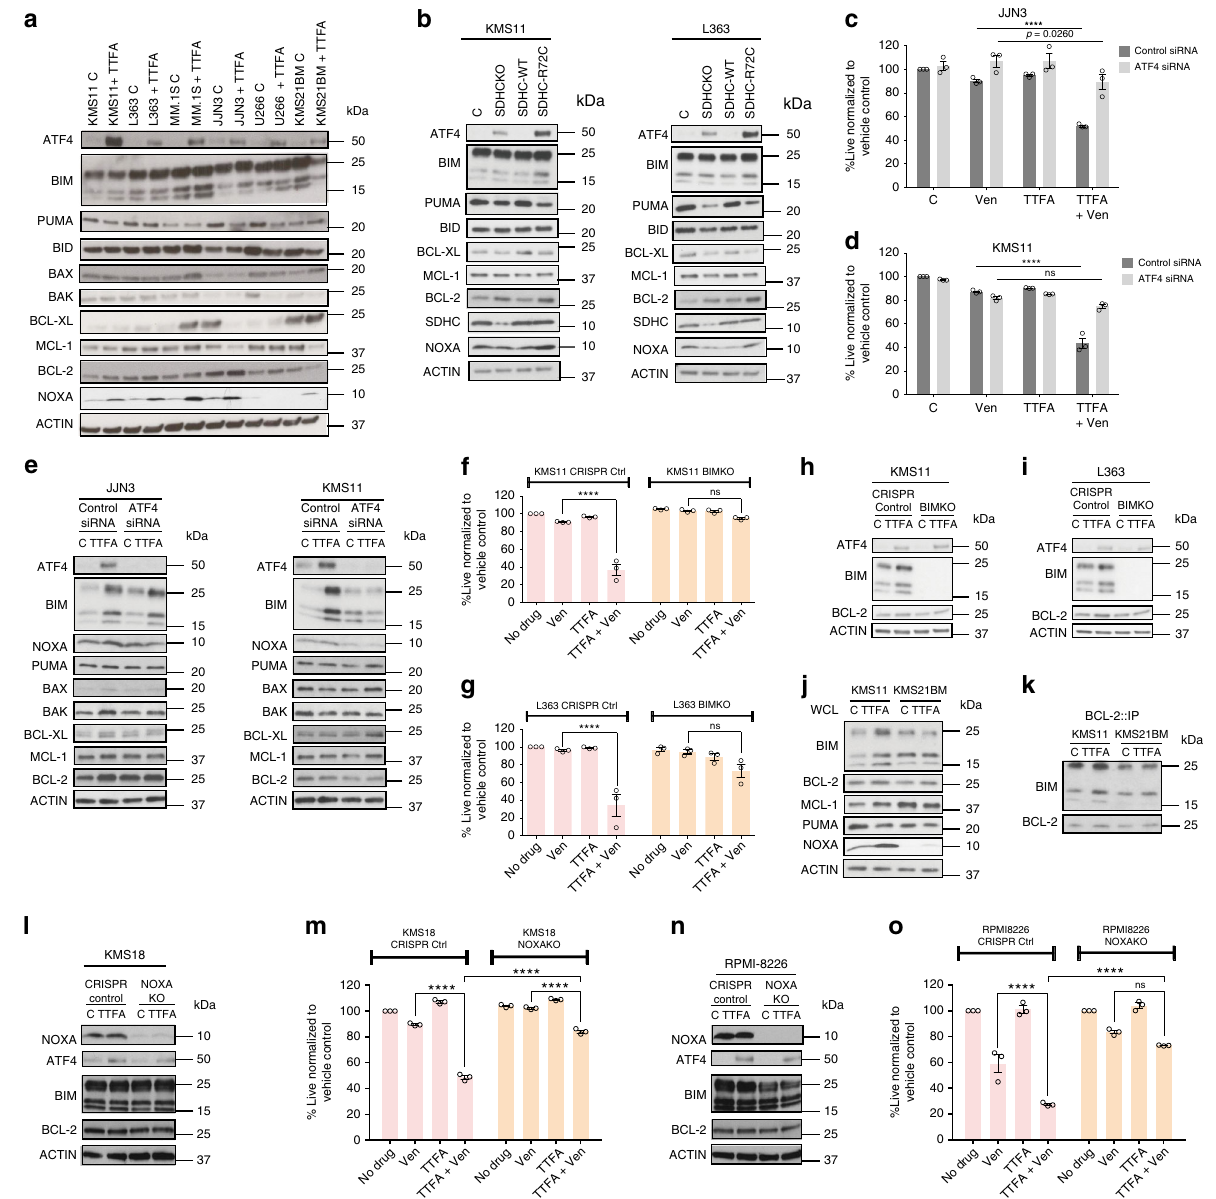
Fig. 5 ATF4, BIM and NOXA regulate TTFA-induced venetoclax sensitivity in MM. a Expression of ATF4 and the indicated pro- and antiapoptotic proteins was evaluated in whole cell lysates of the indicated lines treated with ±100 μ M TTFA for 24 h with Actin as loading control. Representative blots from one of three independent experiments is presented. b Protein expression levels were evaluated in SDHC-WT or SDHC-R72C mutant-expressing cells. c , d Control siRNA or ATF4 siRNA-transfected KMS11 or JJN3 cells were treated with venetoclax (0.5 μ M), TTFA (100 μ M) or the combination for 24 h and cell viability assessed by AnnexinV/DAPI fl ow cytometric staining. n = 3 independent experiments. Data are presented as mean values ± SEM. e Cells